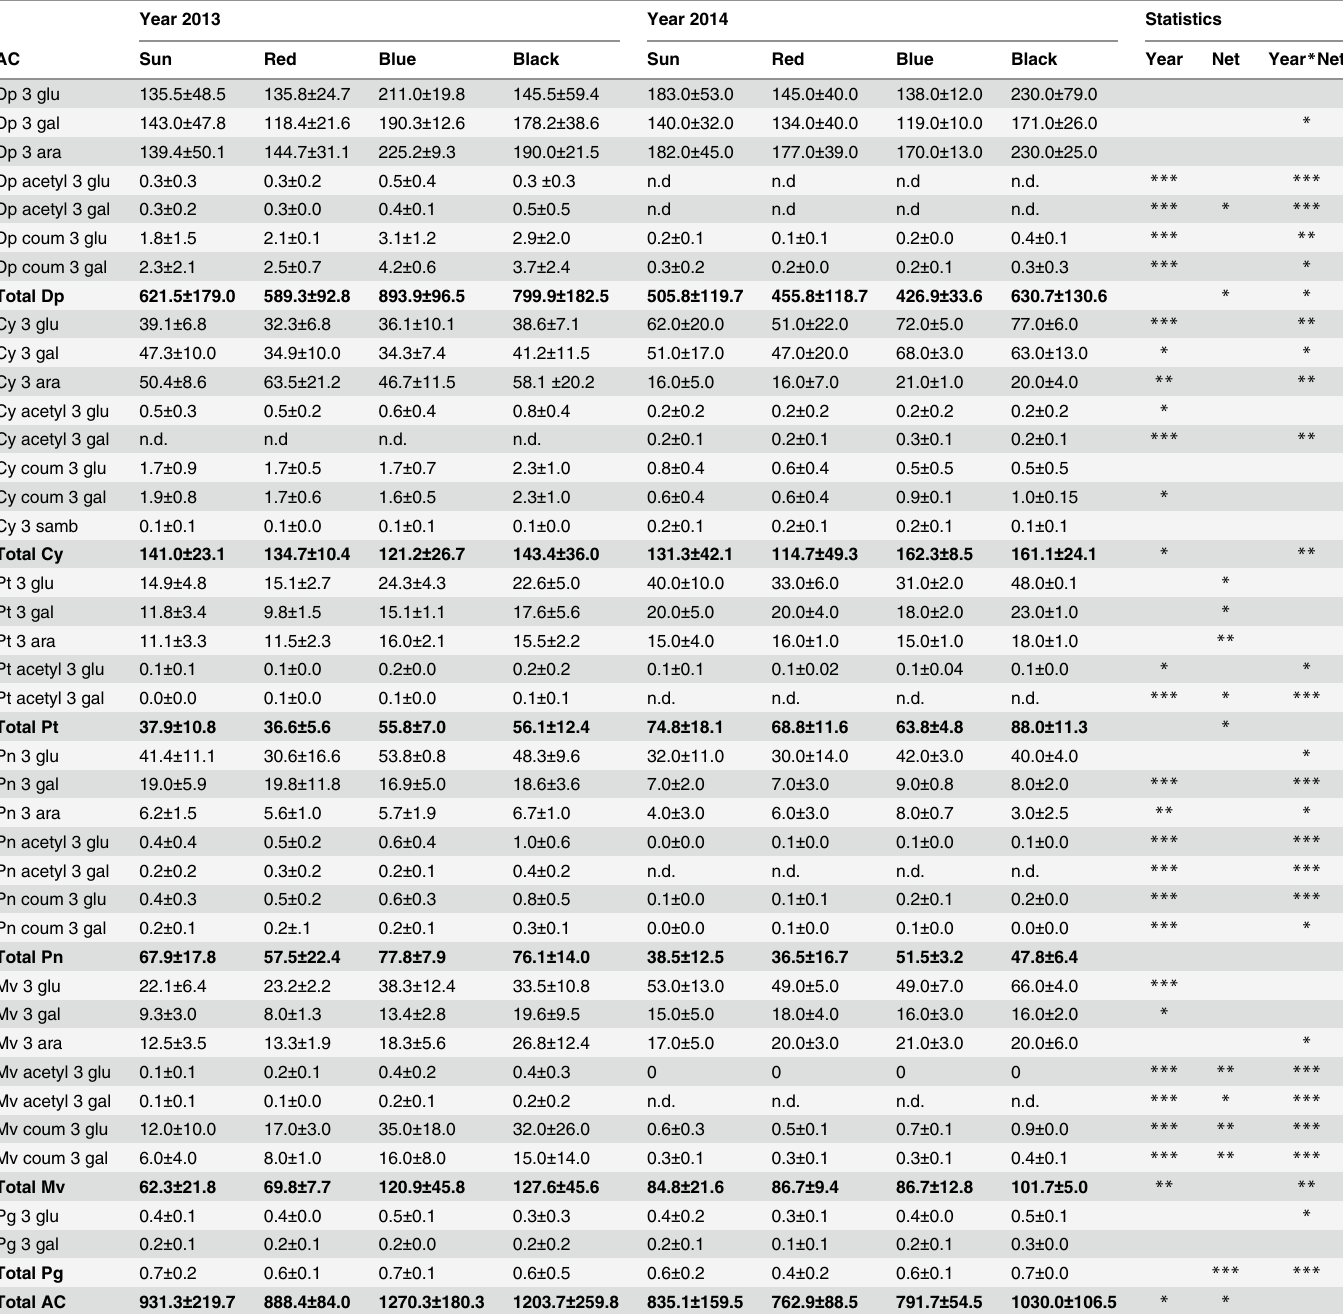
Table 2. List of anthocyanins (AC) identified in wild bilberries grown under different photo-selective nets during 2013 and